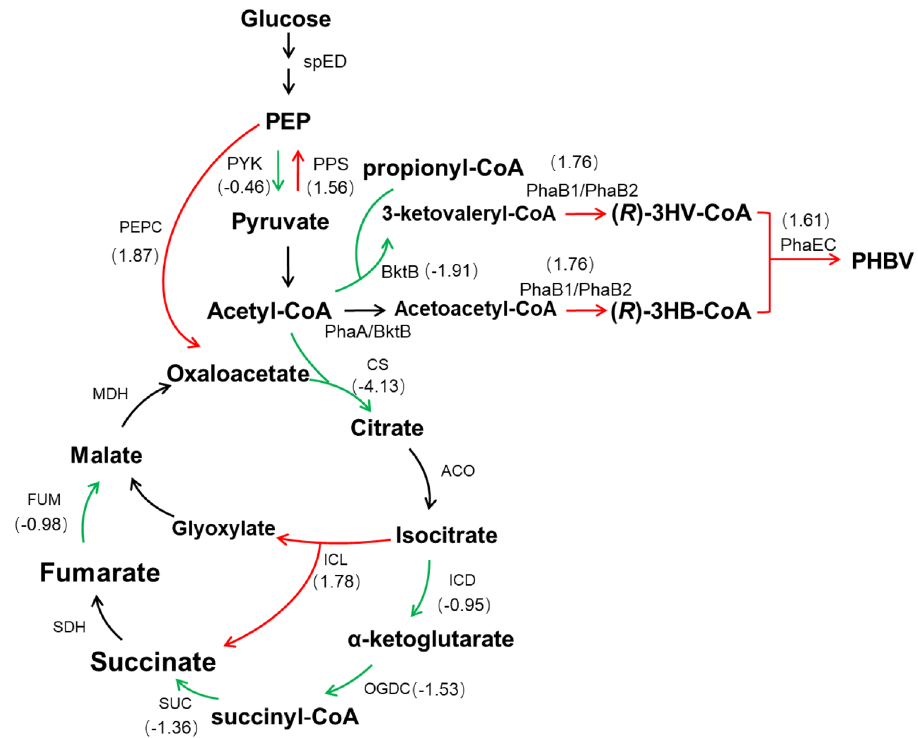
Fig. 7 Effects of inhibition of citrate synthase genes on metabolism of H. mediterranei . Red and green arrows indicate upregulation and downregulation of gene expression, respectively. Numbers in brackets are log 2 (fold change). CS citrate synthase, ACO aconitase, ICD isocitrate dehydrogenase, OGDC α - ketoglutarate dehydrogenase, SUC succinyl-CoA synthetase, SDH succinate dehydrogenase, FUM fumarase, MDH malate dehydrogenase, PEP phosphoenolpyruvate, PEPC, PEP carboxylase, PYK pyruvate kinase, PPS phosphoenolpyruvate